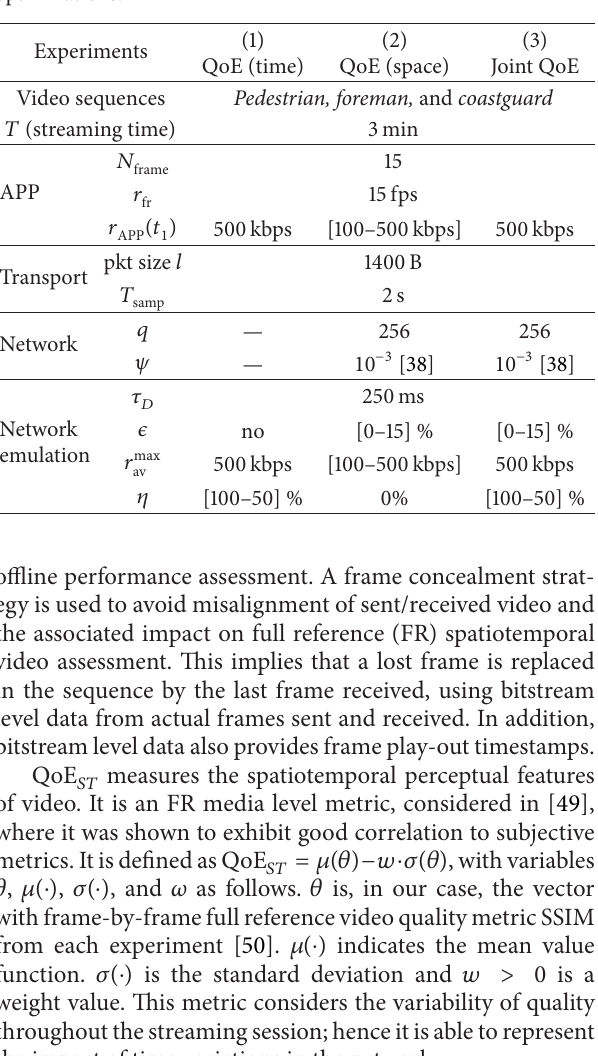
Table 2: Parameters in experimental setup for time and space